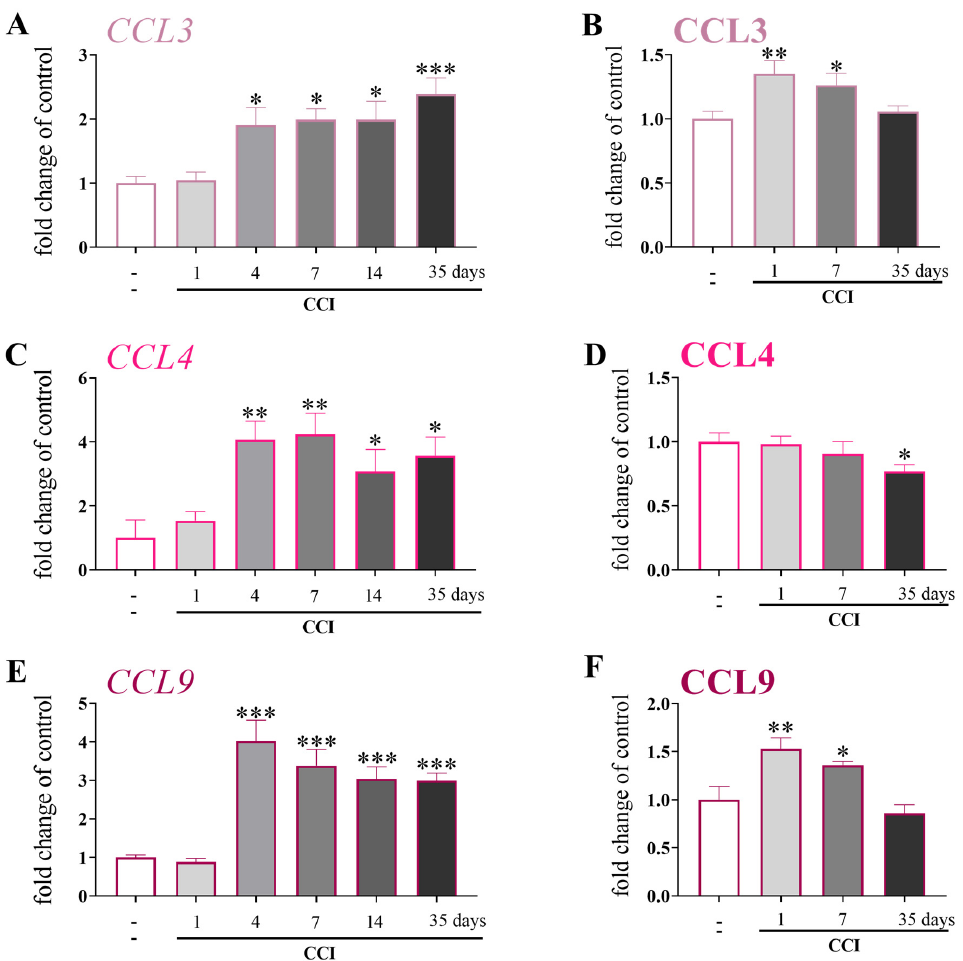
Figure 2 Figure 2. Time-dependent changes in the mRNA levels of CCL3 ( A ) , CCL4 ( C ), and CCL9 ( E ) measured via RT-qPCR and changes in the protein levels of CCL3 ( B ), CCL4 ( D ), and CCL9 ( F ) measured using ELISA in the spinal cord of naive and CCI-exposed mice (from 1 to 35 days). The data are presented as the mean fold changes relative to the control ± SEM (n = 4–10). The results were evaluated using one-way ANOVA followed by Bonferroni’s post hoc test for comparisons of selected pairs. * p < 0.05, ** p < 0.01, and *** p < 0.001 indicate significant differences vs. the naive group. Abbreviations: -: naive; CCI: chronic constriction injury of the sciatic